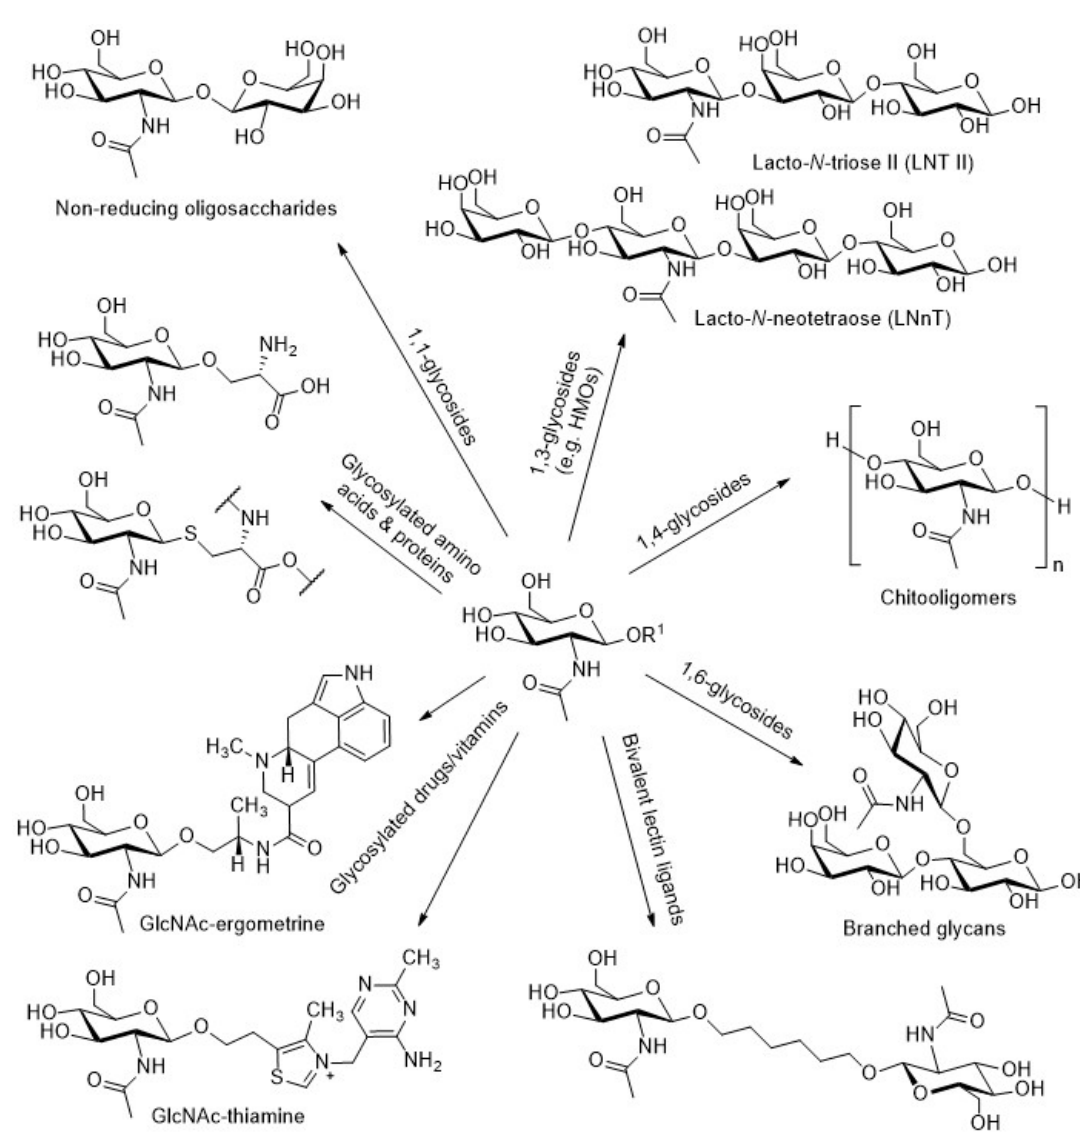
Figure 1. Products from GH20-catalyzed trans-glycosylation reactions.